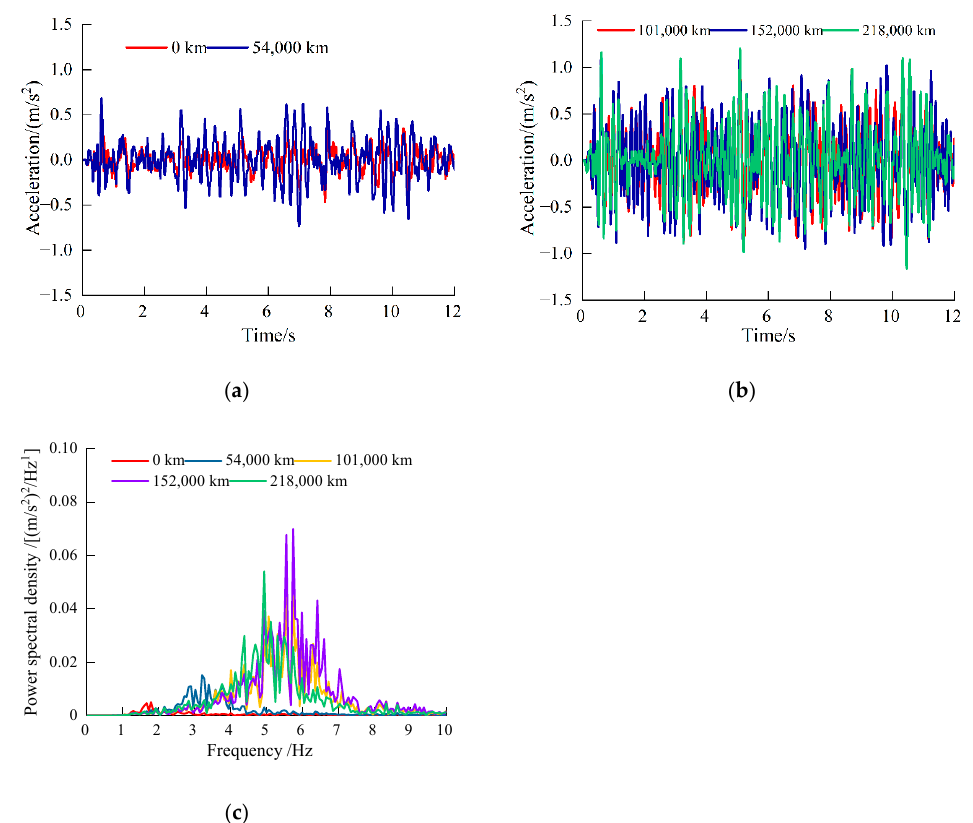
Figure 11. Vibration on carbody ends for the Line A: ( a ) time ‐ domain of the service distance less than 54,000 km; ( b ) time ‐ domain of the service distance more than 101,000 km;( c ) frequency domain.